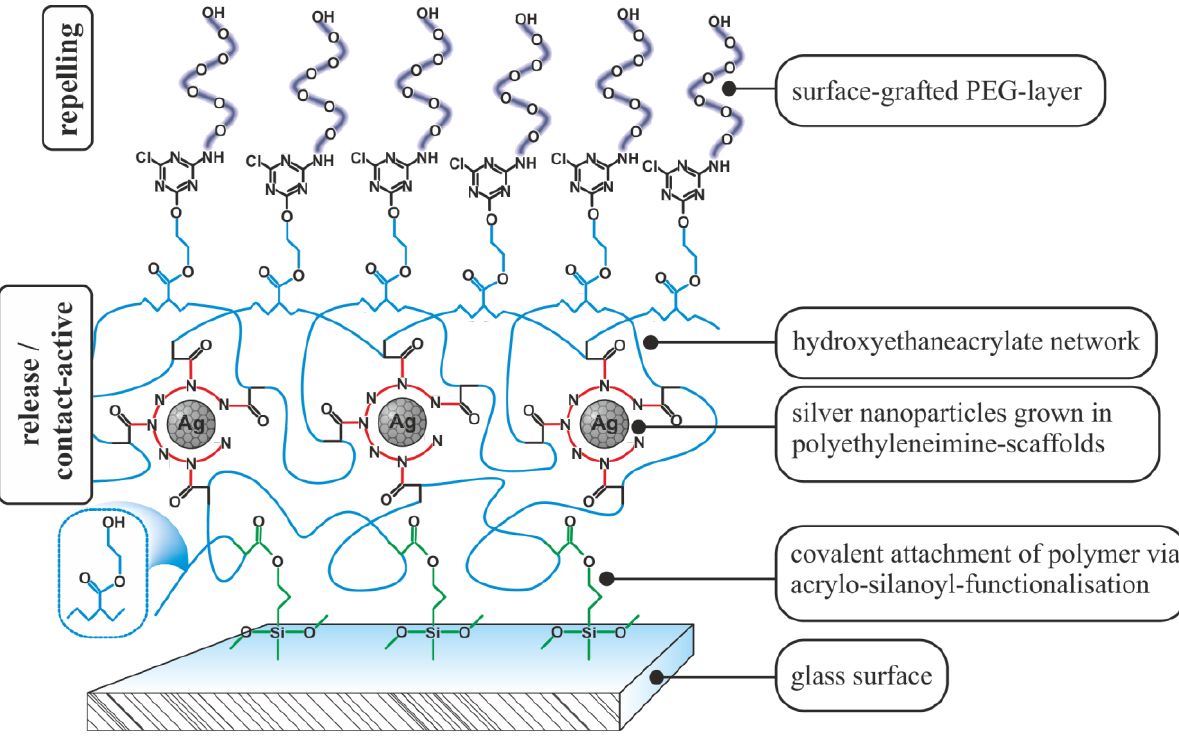
Figure 10. Concept of repel and release of a designed network. Created according to